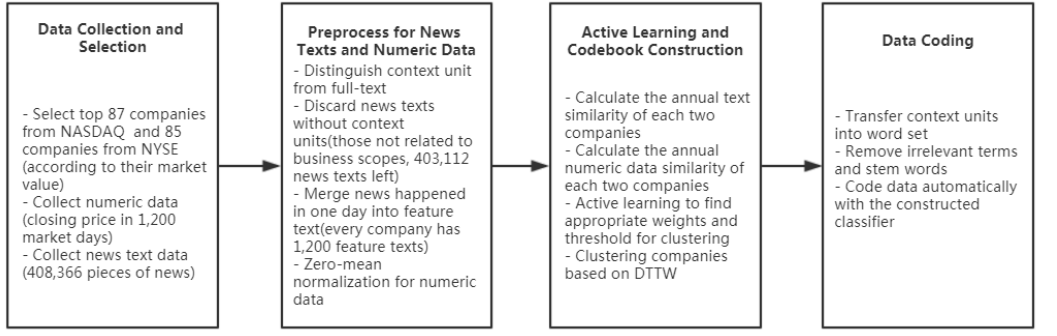
Figure 1. Overview of data processing. NASDAQ: National Association of Securities Dealers